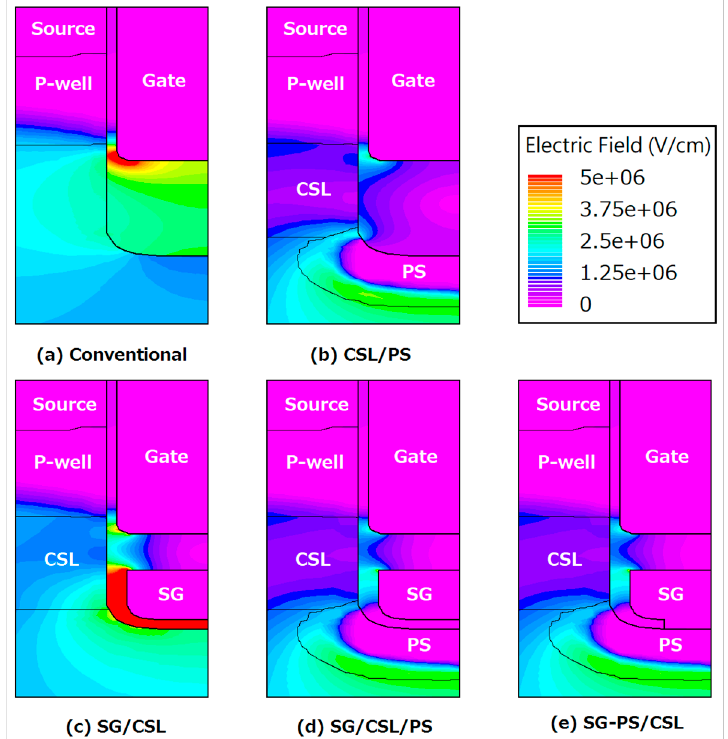
Figure 4. The electrical field distribution in different gate designs at Vds = 1600 V. The devices without PS ( a , c ) show a relative high electric field at the gate trench bottom corner. In simulation, P-well and SG are connected to the source electrode through virtual contacts at locations indicated in Figure 1.